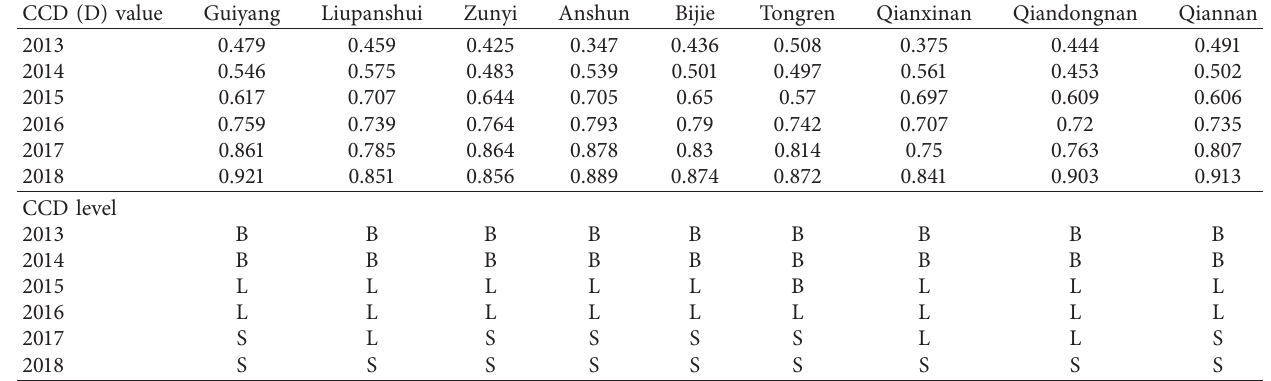
Table 5: CCD values and levels of each prefecture in Guizhou.